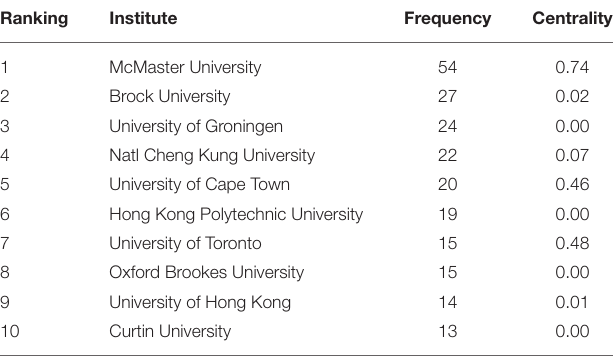
TABLE 2 | Top 10 prolific institutes in research of children with DCD,